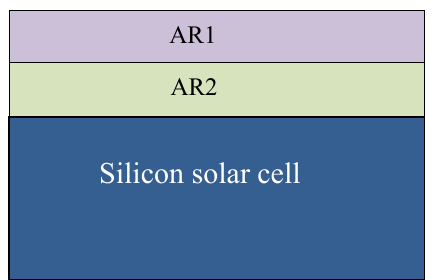
Fig. 1 . Schematic view of DLARCs (AR1 and AR2) on the Si Solar